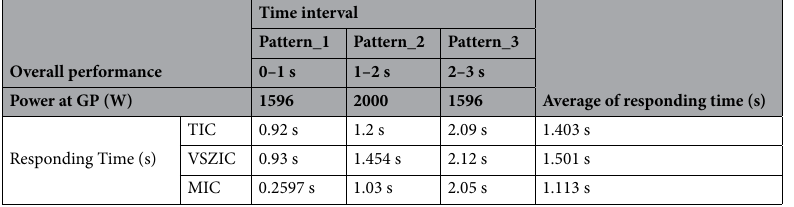
Table 3. Experimental performance during radiation patterns for MIC with TIC and VSZIC